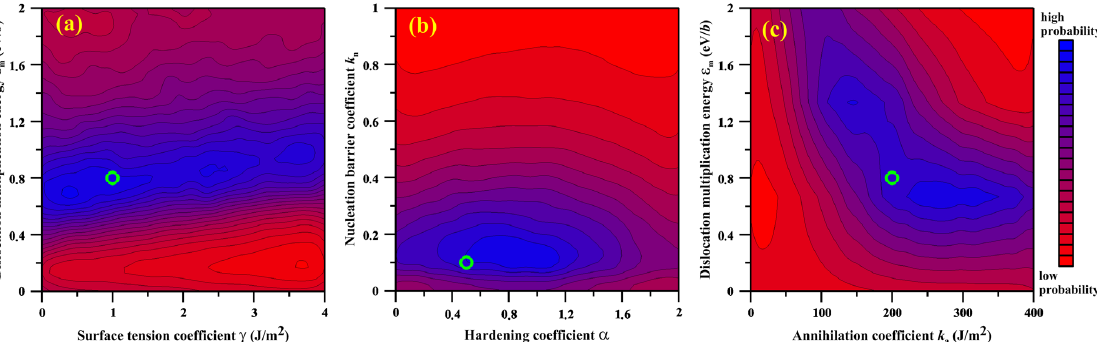
Figure 10. Results of Bayesian identification of parameters of the model of plasticity and fracture by means of comparison with the MD. Distribution of probability in the parameter space represented through ( a ) γ − ε m plane, ( b ) α − k n plane, and ( c ) k a − ε m plane, where γ is the surface tension coefficient, ε m is the dislocation multiplication energy from the dislocation multiplication term, α is the hardening coefficient from the Taylor hardening law, k n is the coefficient of the energy barrier of dislocation nucleation from the nucleation term, and k a is the coefficient of annihilation of dislocations. The selected parameters are shown by a green circle and collected in Table 1.